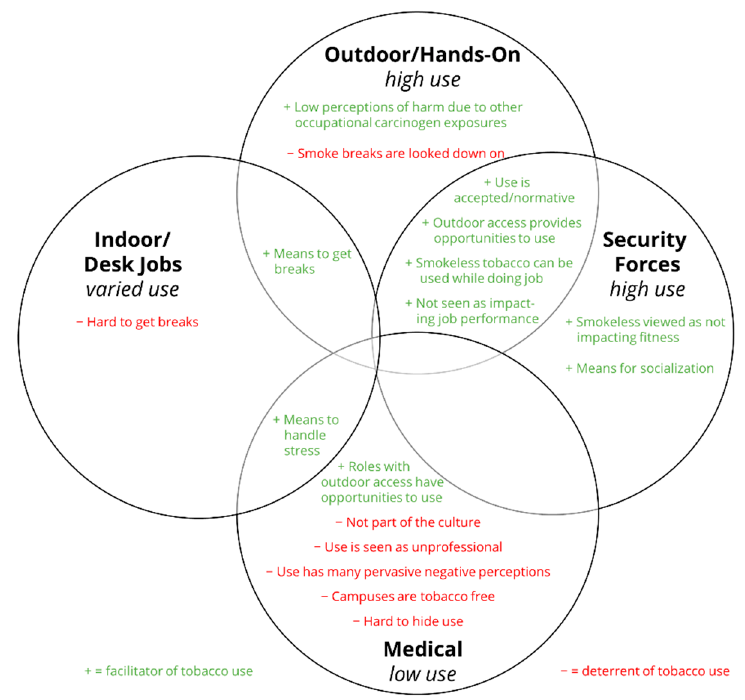
Figure 1. Facilitators and Deterrents of Tobacco Use by Career Field. Table 3. Exemplar Quotes Describing Facilitators and Deterrents of Tobacco Use by Career